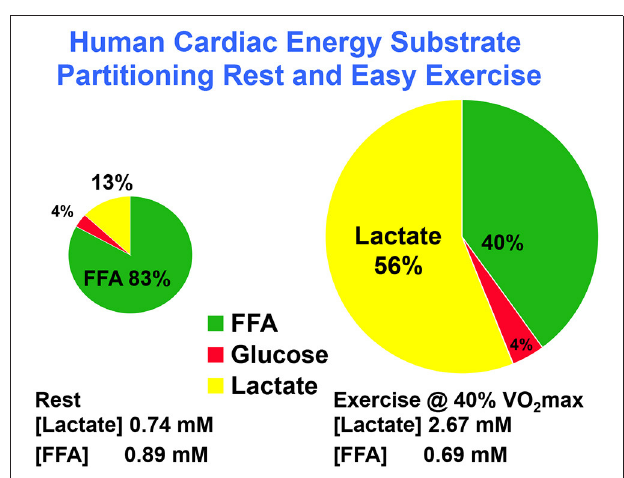
FIGURE 2 | Illustration of substrate–substrate interactions in cardiac metabolism as determined in a man resting or engaged in easy, 40% VO 2 max exercise. Results show that the contribution of lactate to cardiac energy need depends on arterial lactate concentration and is significantly greater than that of glucose. Results also show crossover from fatty acid to lactate dependence in heart during exercise. Data from